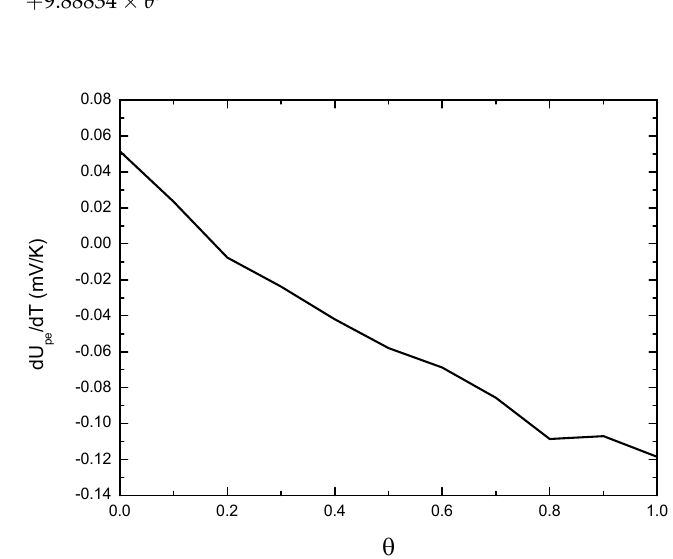
Figure A4. Temperature gradient of the OCP curve for the LFP electrode as a function of SOC.